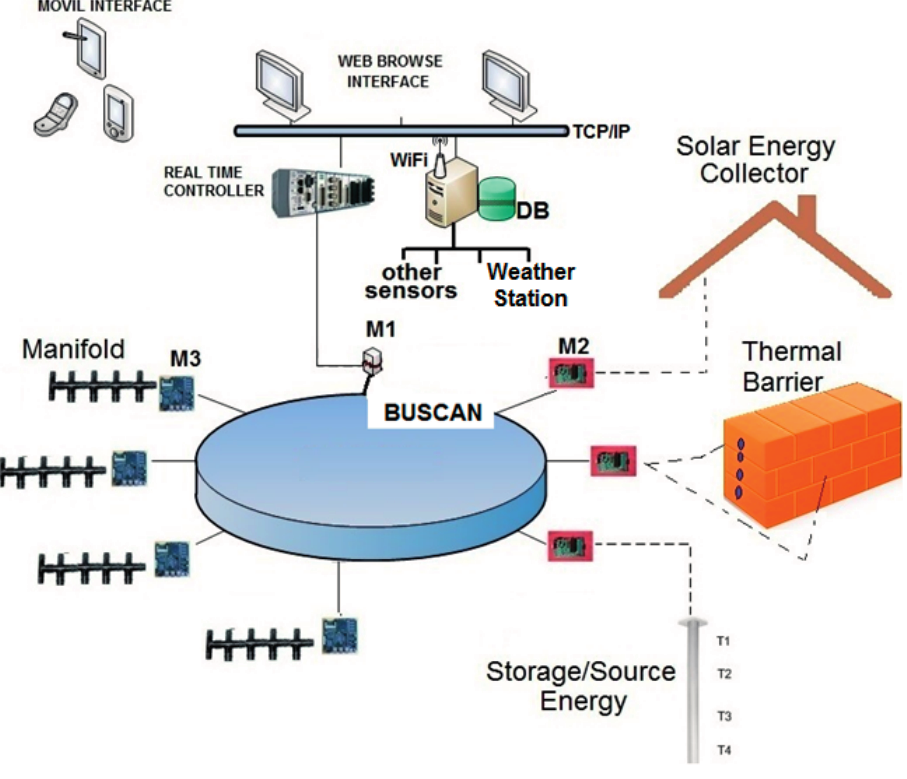
Figure 11. Level 1: Sensor and communication